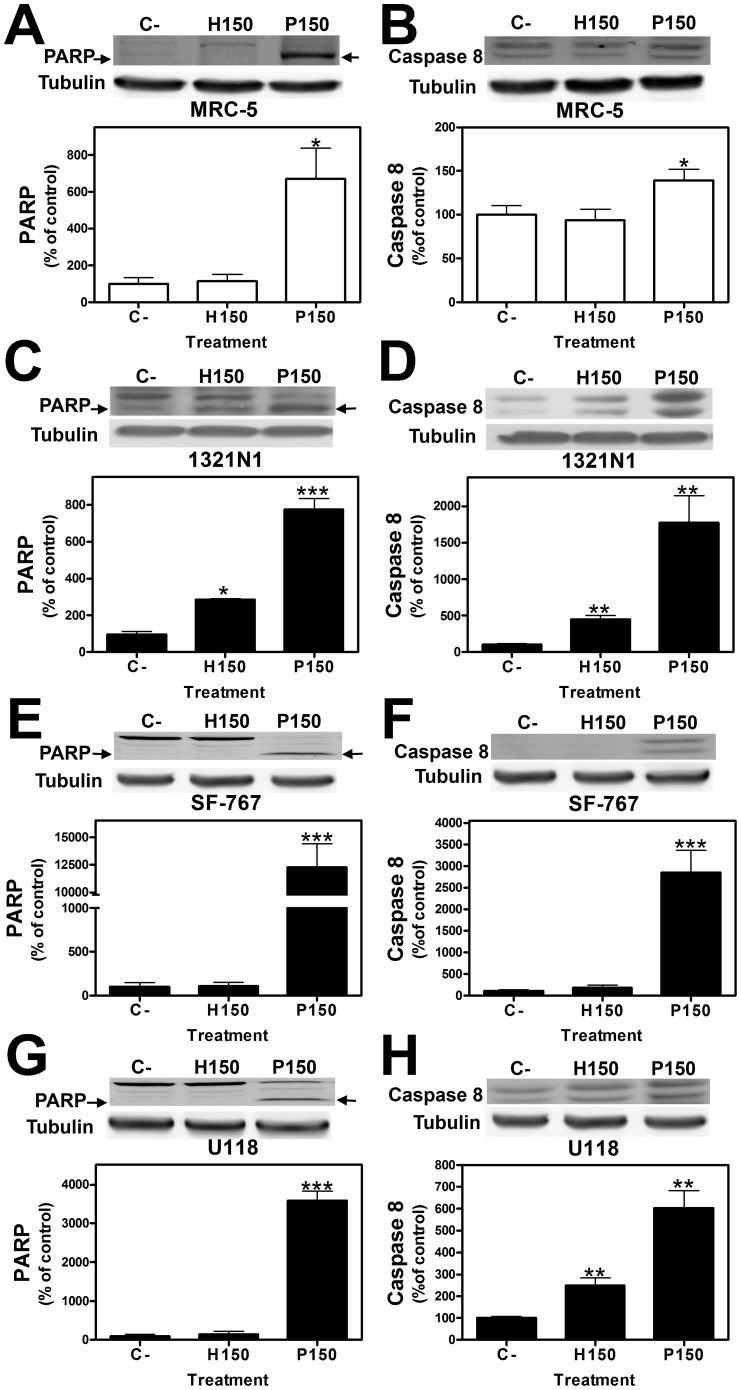
Expression of PARP and Caspase 8 in 1321N1, SF-767, U118 human glioma cells and non cancer MRC-5 cells after treatment with 2OHOA.PARP and Caspase 8 proteins in 1321N1, SF-767, U118 human glioma cells and MRC-5 non cancer cells. Upper panels: a representative immunoblot showing PARP (A, C, E and G) or Caspase 8 (B, D, F and H) expression in every cell line after exposure to 2OHOA (H) or palmitate (P: 150 µM; 72 hours). Lower panels: Bar diagram showing the mean±SEM values of PARP expression in MRC-5 (A), 1321N1 (C), SF-767 (E) and U118 (G) cells or Caspase 8 in MRC-5 (B), 1321N1 (D), SF-767 (F) and U118 (H) cells after exposure to 2OHOA (H) or palmitate (P: 150 µM; 72 h) when compared with untreated controls (C, *p<0.05, **p<0.01, ***p<0.001; n = 6).